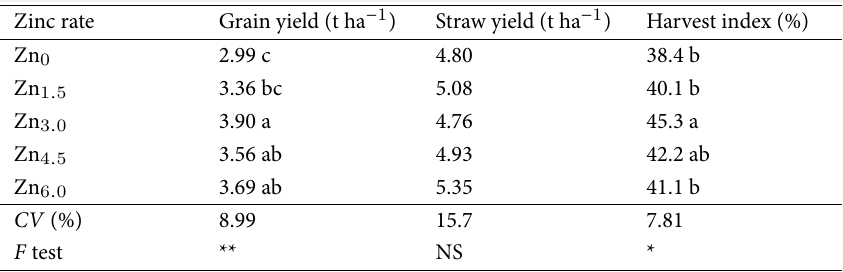
Table 4 Grain and straw yields of wheat influenced by Zn rates.